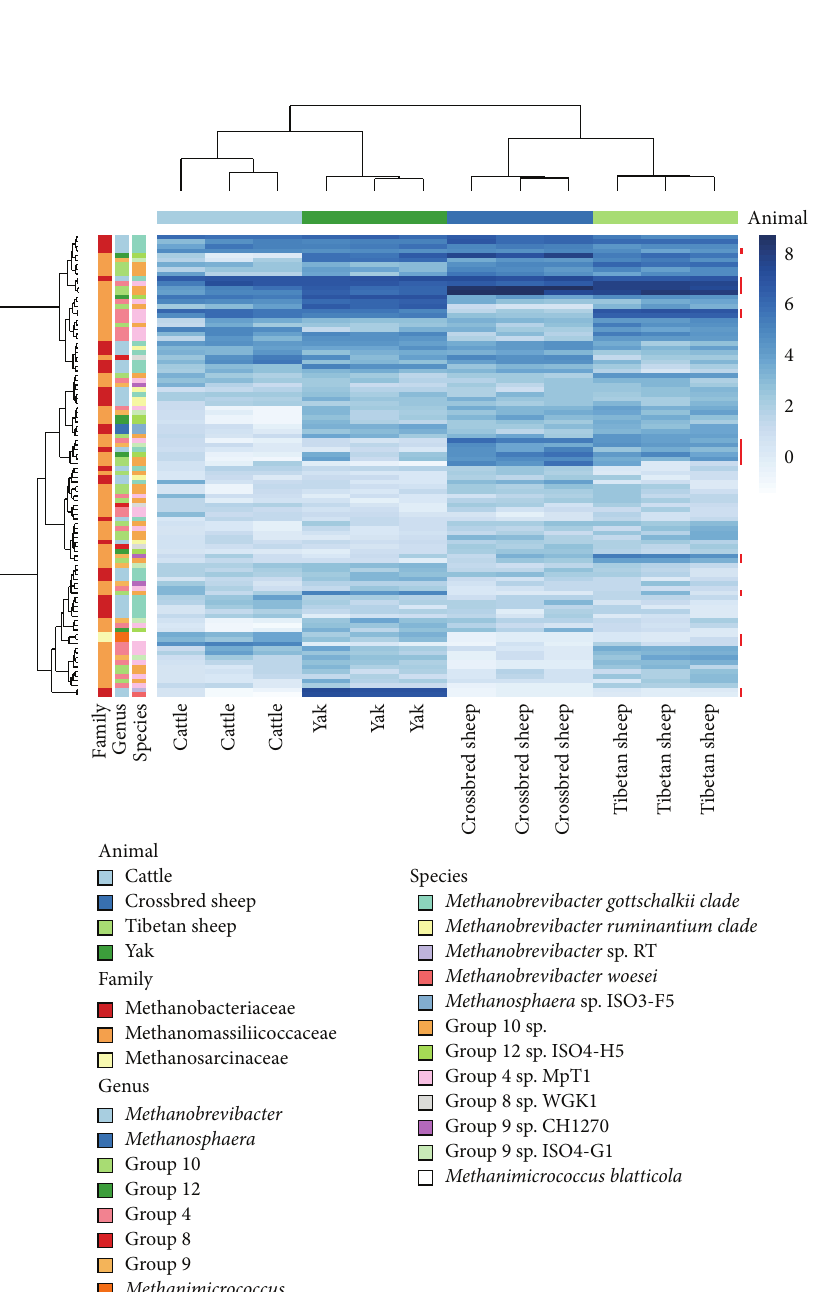
Figure 2: Rumen methanogen community heat maps and clustering of themost abundant 100 OTUs using regularized log transformed values from DeSeq2. Ward’s minimum variance method was used for hierarchical clustering of the computed distance matrix for samples based on the Jaccard dissimilarity indices of the OTU data in the vegan package. The red bar indicates significant OTUs clustering for host species. See Supplementary Figures 3, 4, 5, 6, and 7 for further details with respect to animal pairwise